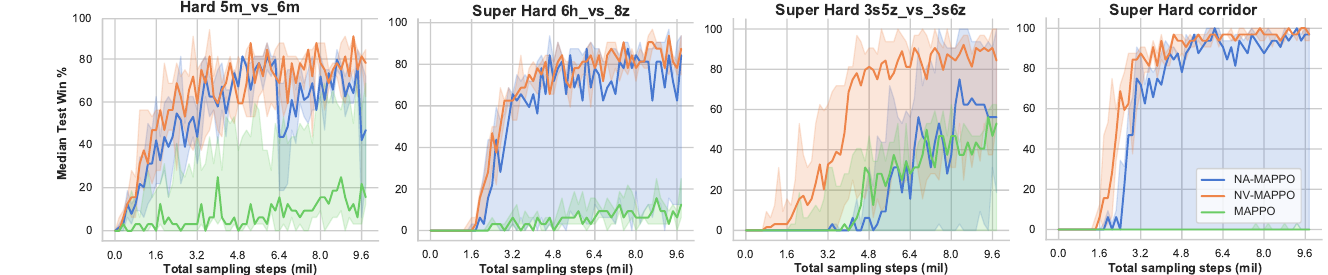
Figure 6. The training curves of proposed methods in some Hard and Super-Hard scenarios.